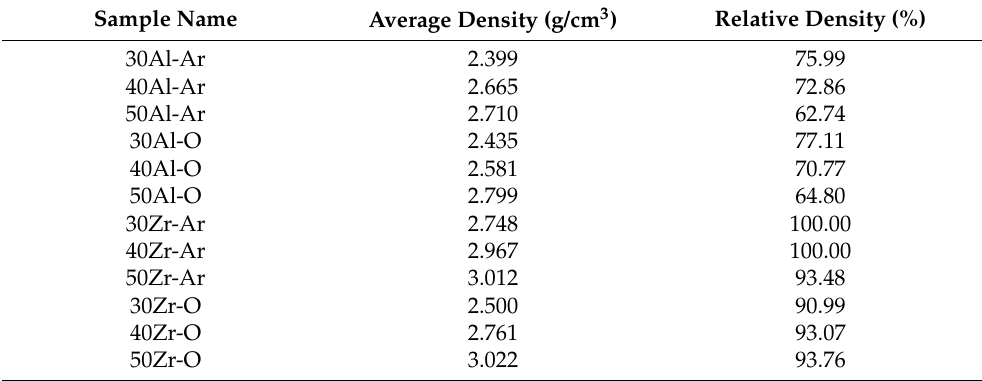
Table 2. Density results of the